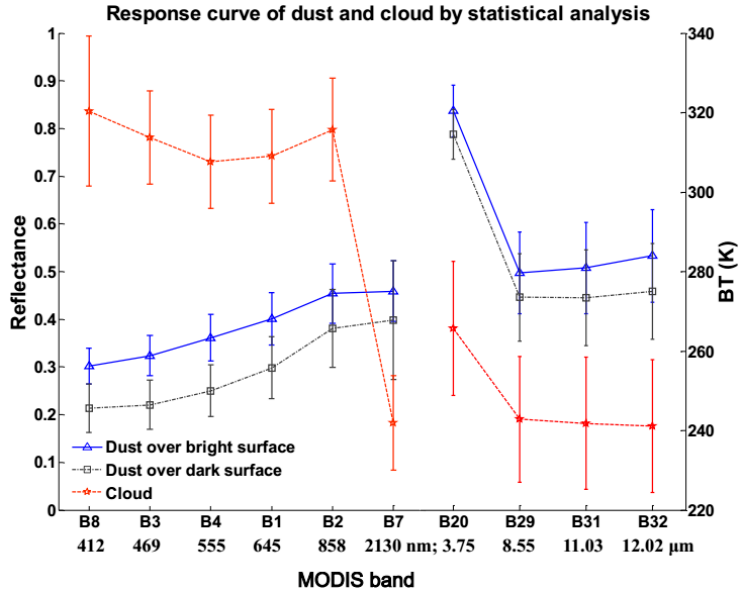
Figure 1. Response curves of dust and cloud (left y -axis corresponds to B8, B3, B4, B1, B2, and B7; right y -axis corresponds to B20, B29, B31, and B32). Red line: the reflectance/bright temperature of the cloud.